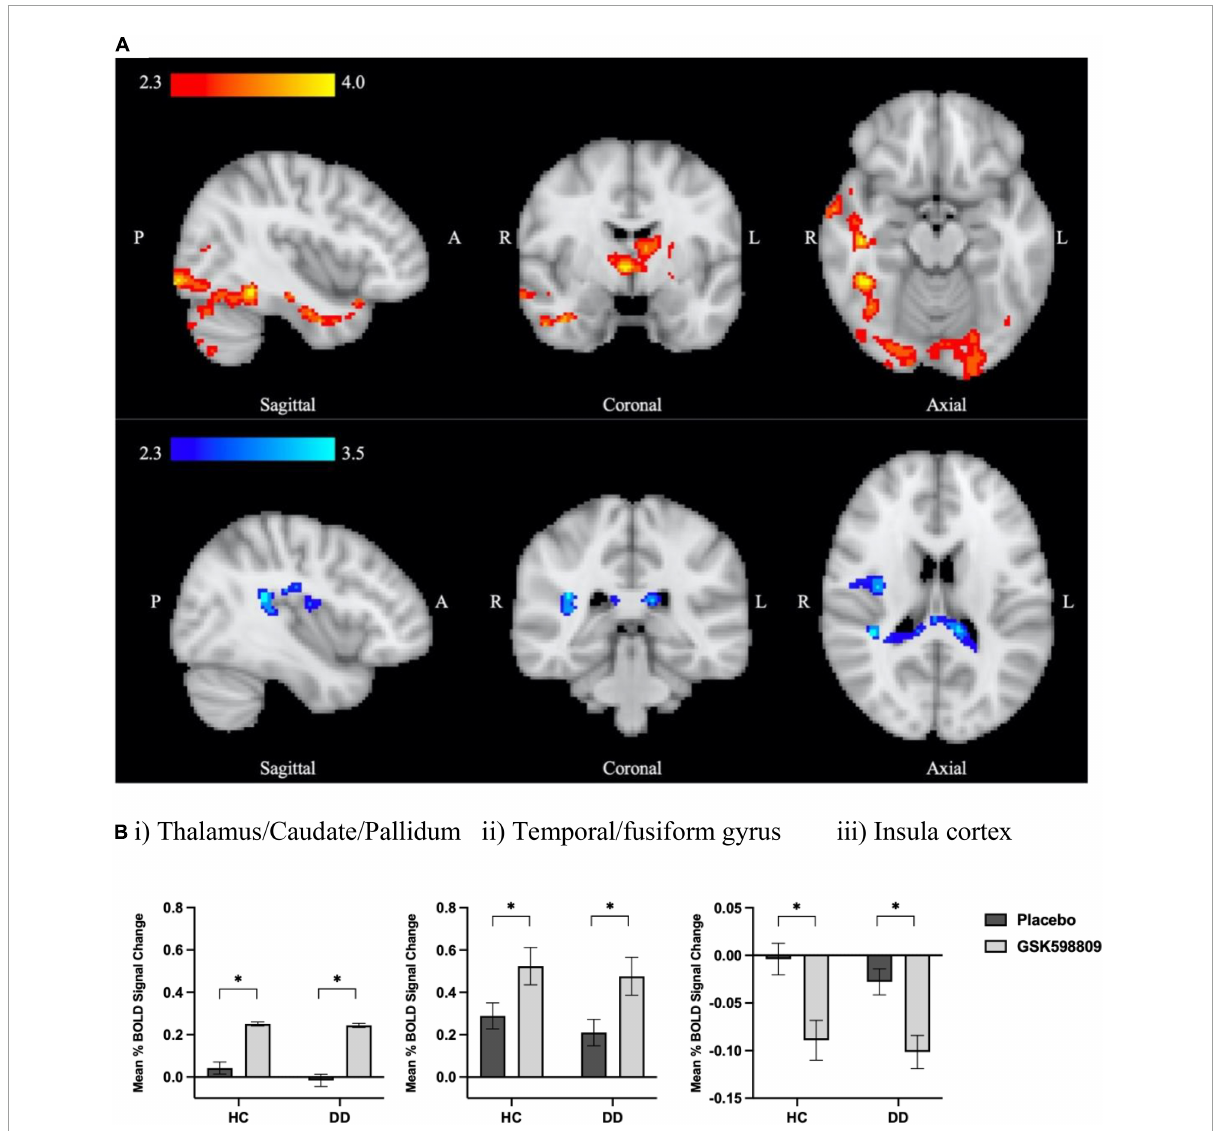
FIGURE3 BOLD signal change following D3 receptor antagonism in response to aversive image processing. (A) Average BOLD signal change in aversive > neutral contrast following D3 antagonism relative to placebo (inputs were drug difference images for GSK598809-placebo) derived from a whole brain analysis using FSL’s FLAME-1 in HC and DD groups ( n = 68). Color bars show z -stat values (threshold Z > 2.3, P < 0.05 corrected). Red colors indicate increased BOLD signal for the effect of drug (GSK598809 – placebo, MNI coordinates: x = 41.9, y = –4.7, z = –16.5), and blue colors indicate decreased BOLD signal (MNI coordinates: x = 39.2, y = –34.4, z = 18.2). (B) BOLD signal change in extracted clusters in HC ( n = 32) and DD ( n = 36) groups in (i) thalamic/caudate/pallidum cluster, (ii) temporal/fusiform gyrus cluster, and (iii) insula cluster. NB: there is no overlap between this insula cluster and that found to be altered in the polydrug versus alcohol-only subgroup comparison in Figure 2 ; they were lateralised to right and left hemispheres respectively. Data are mean ± SEM. ∗ Indicates significant difference as determined by whole brain analysis in (A)